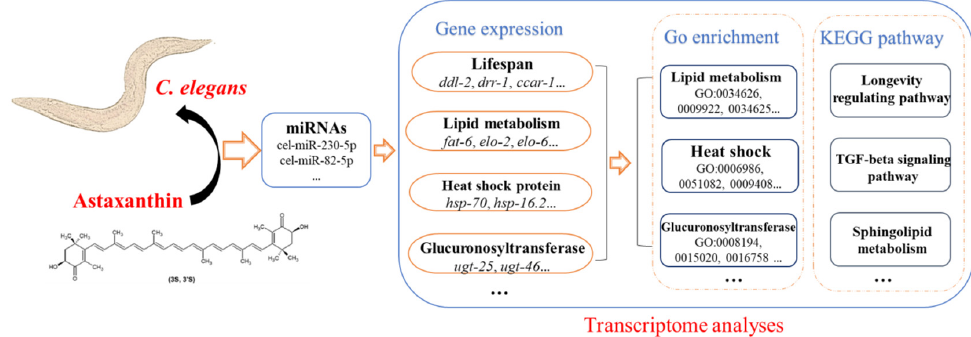
Figure 8. Transcriptomic analyses of C. elegans treated with astaxanthin.